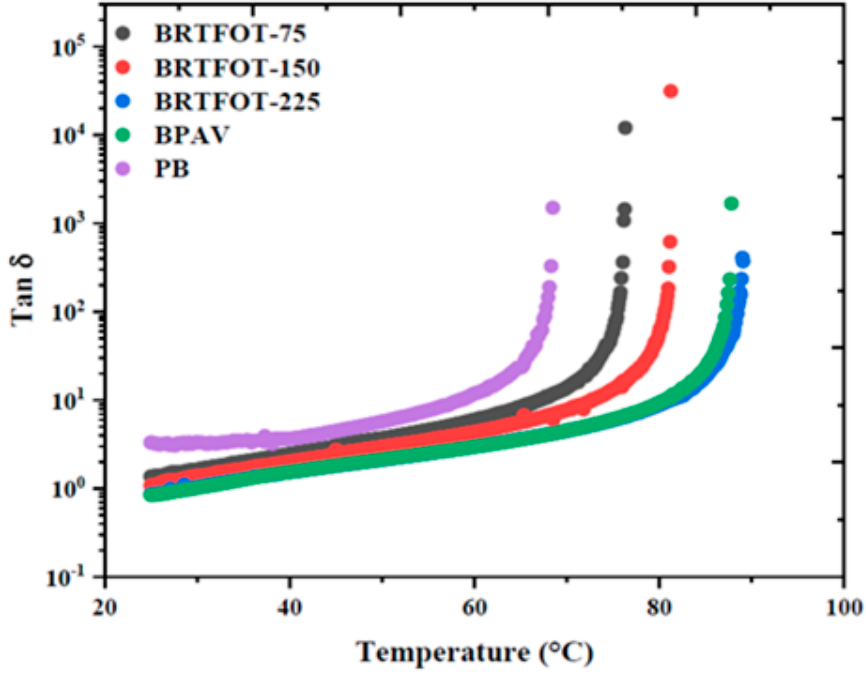
Figure 3. Temperature dependence (in the range 25 to 100 °C) of the loss tangent for pristine (PB) and aged bitumen samples (BRTFOT-75; BRTFOT-15; BRTFOT-225 and BPAV).